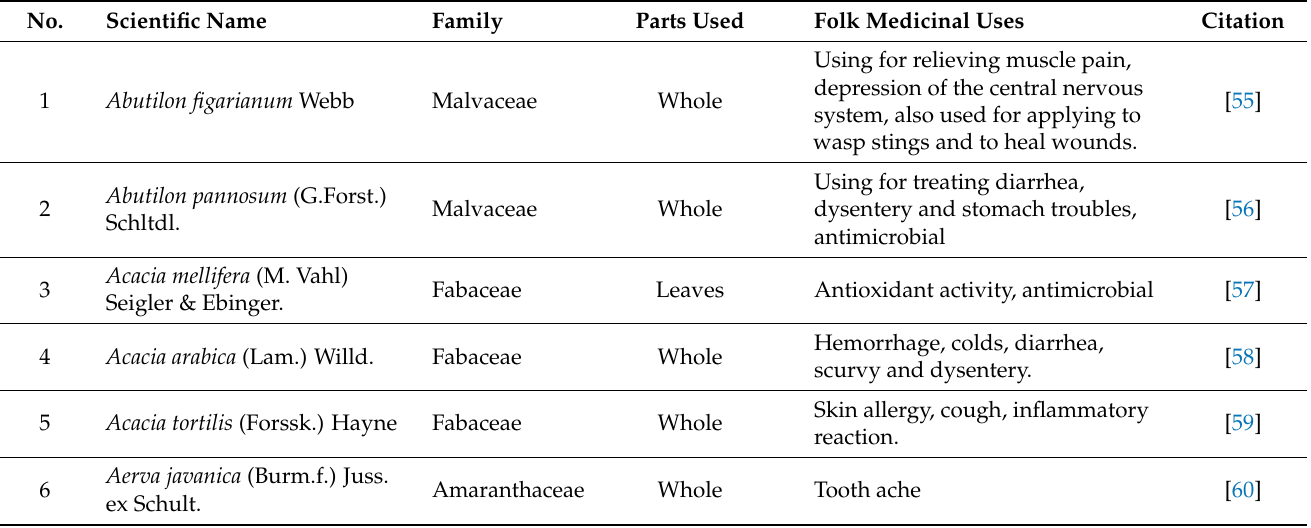
Figure 3. Family diversity abundance in Aljumum within the study areas. Table 3. Medicinal uses of ethnobotanical confined species in Aljumum region, Saudi